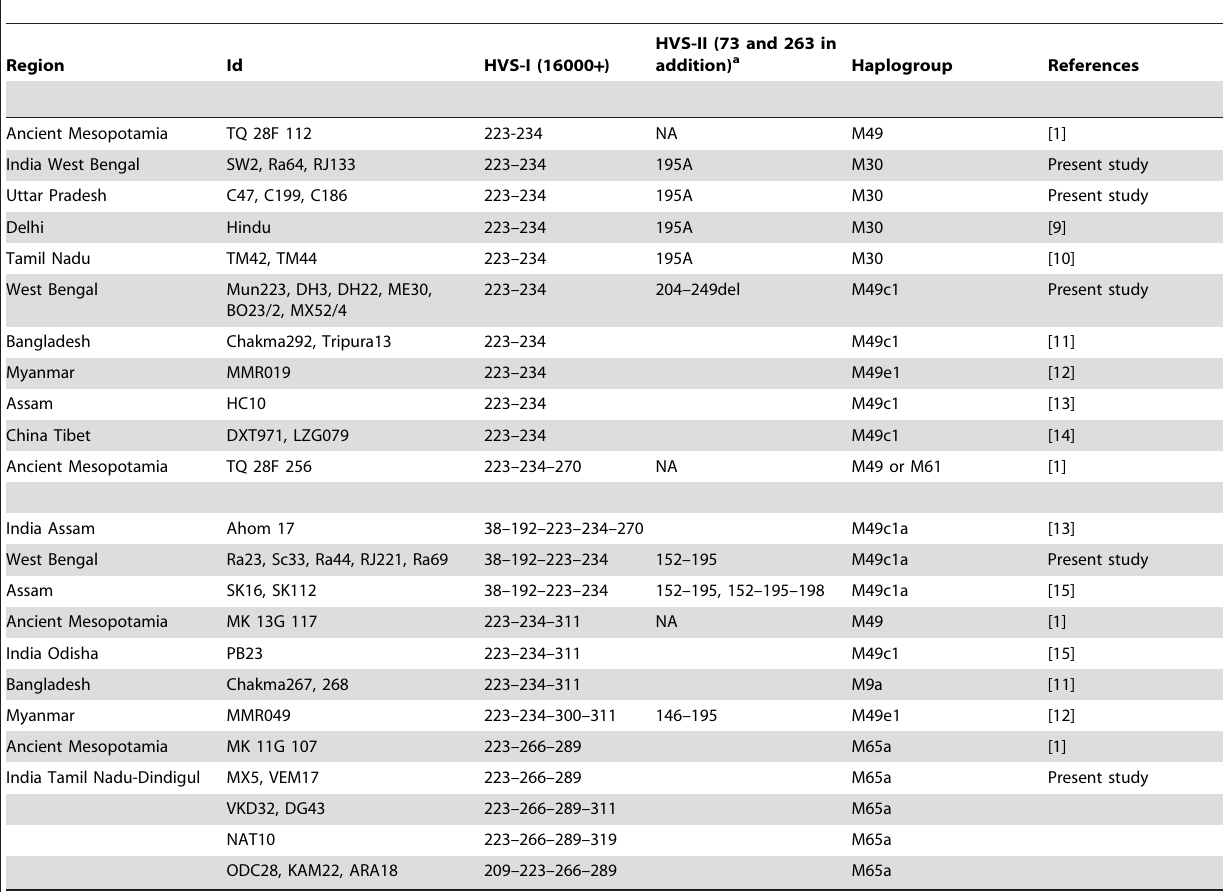
Table 1. mtDNA haplotype affiliated with the ancient Mesopotamian and related sequences in the Indian subcontinent.